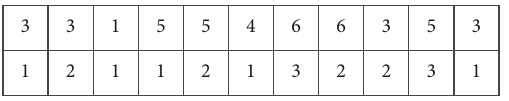
Figure 5: A new solution of HS.